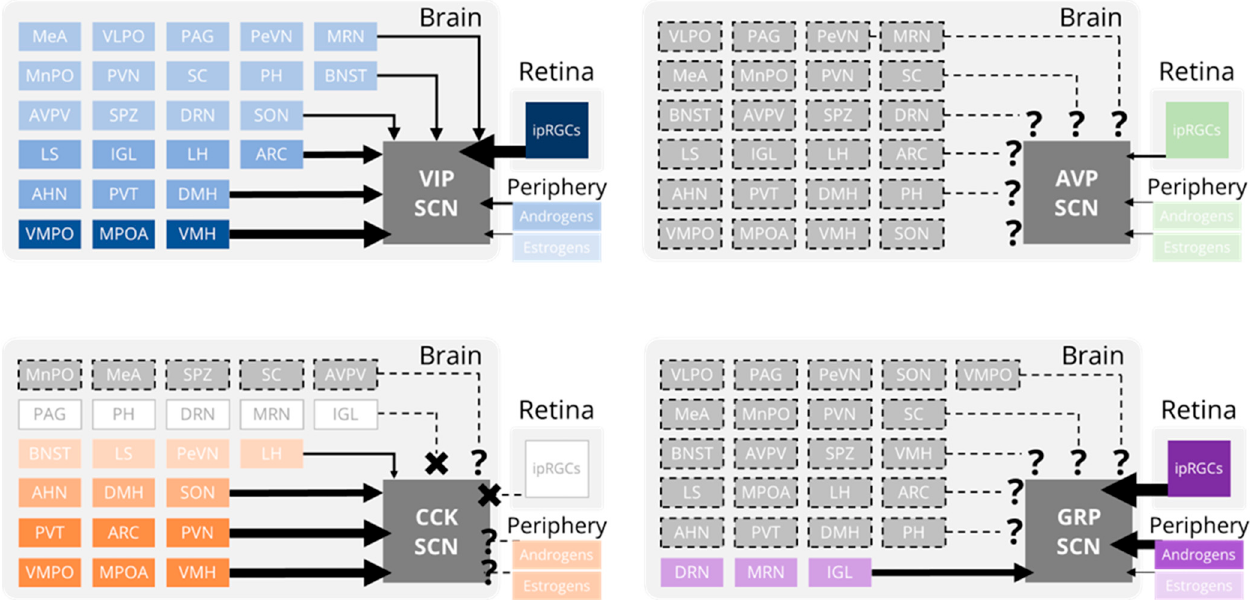
Figure 2. Inputs to the SCN. Schematics depicting the relative strengths of synaptic and hormonal inputs onto vasoactive intestinal peptide (VIP, blue), arginine vasopressin (AVP, green), cholecystokinin (CCK, orange), and gastrin-releasing peptide (GRP, purple) producing suprachiasmatic nucleus (SCN) neurons. Darker colors and thicker arrows represent stronger inputs from a given brain region or hormone. Gray boxes with no dashed outlines indicate brain regions with no inputs to an SCN subpopulation. Gray boxes with dashed outlines indicate brain regions whose (absence of) projections to an SCN subpopulation have not been experimentally determined. AHN, anterior hypothalamic nucleus; ARC, arcuate nucleus; AVPV, anteroventral periventricular nucleus; BNST, bed nucleus of the stria terminalis; DMH, dorsomedial hypothalamic nucleus; DRN, dorsal raphe nucleus; IGL, intergeniculate leaflet; ipRGCs, intrinsically-photosensitive retinal ganglion cells; LH, lateral hypothalamus; LS, lateral septum; MPOA, medial preoptic area; MRN, median raphe nucleus; MeA, medial amygdala; MnPO, median preoptic area; PAG, periaqueductal gray; PH, posterior hypothalamus; PVN, paraventricular nucleus of the hypothalamus; PVT, paraventricular nucleus of the thalamus; PeVN, periventricular nucleus; SC, superior colliculus; SON, supraoptic nucleus; SPZ, subparaventricular zone; VLPO, ventrolateral preoptic area; VMH, ventromedial hypothalamus; VMPO, ventromedial preoptic